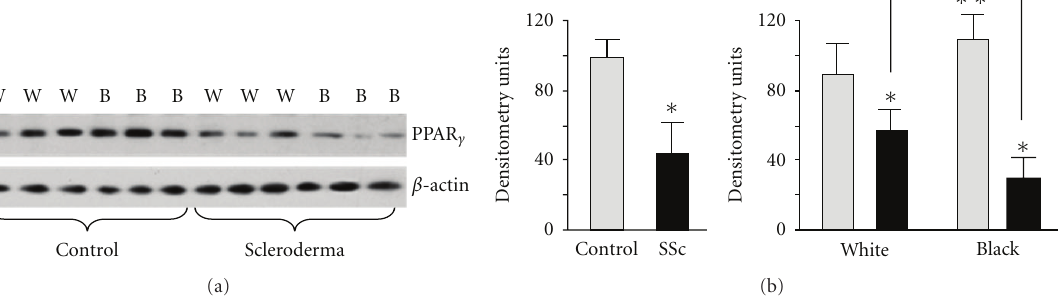
Figure 1: PPAR γ expression in lung fibroblasts. (a) Western blot for PPAR γ on lung fibroblasts isolated from white (W) and black (B) SSc-ILD patients and controls. Anti- β -actin antibody was used as a loading control. (b) Densitometric analysis of PPAR γ in lung fibroblasts ( n = 16) from 3 independent experiments is presented. PPAR γ protein expression was adjusted in accordance with β -actin level. ∗ Statistically significant di ff